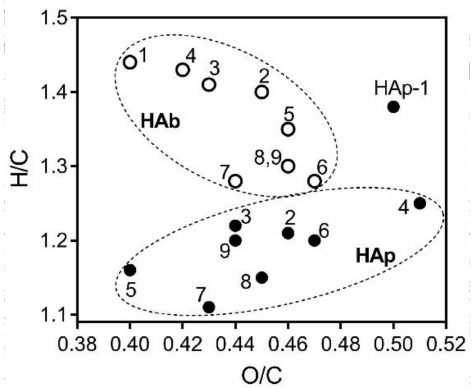
Figure 2. The van Krevelen diagram of H/C versus O/C for the HA fractions. HAs isolated by basic extraction are shown as open circles; HAs isolated by pyrophosphate extraction are shown as solid